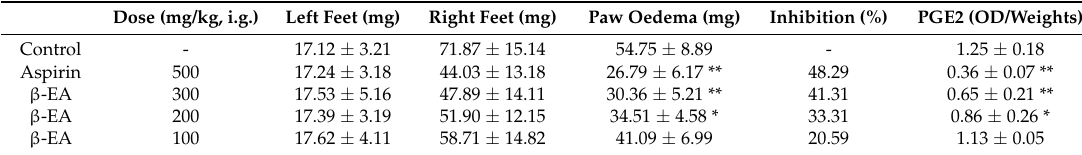
Table 5. Effect of the biflavonoid on carrageenin-induced paw edema in rats ( n = 10). Dose (mg/kg, i.g.)